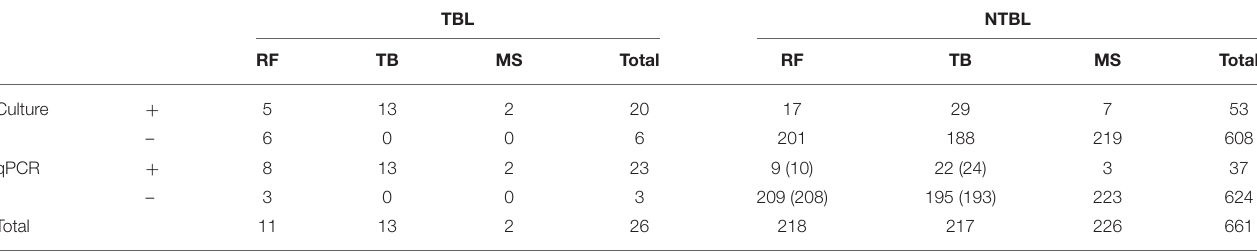
TABLE 1 | Evaluation of the microbiological culture and direct qPCR targeting IS 6110 results obtained upon analyzing 687 lymph nodes, according to the presence or absence of tuberculosis-like lesions. TBL